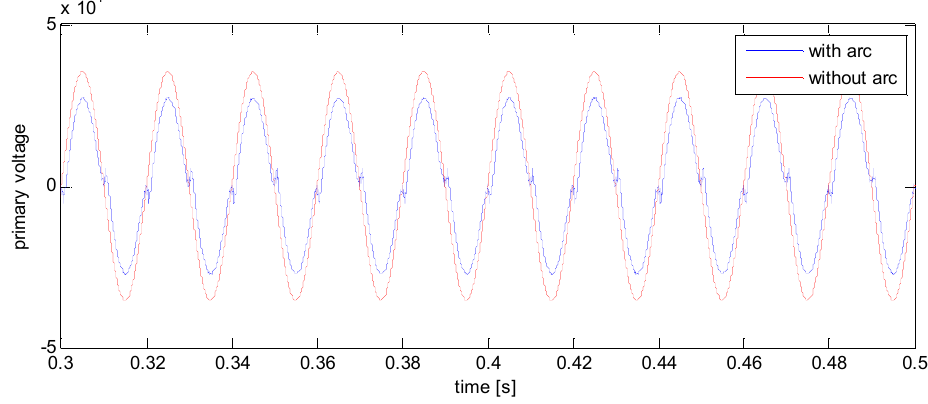
Figure 9. Primary voltage of the traction transformer.